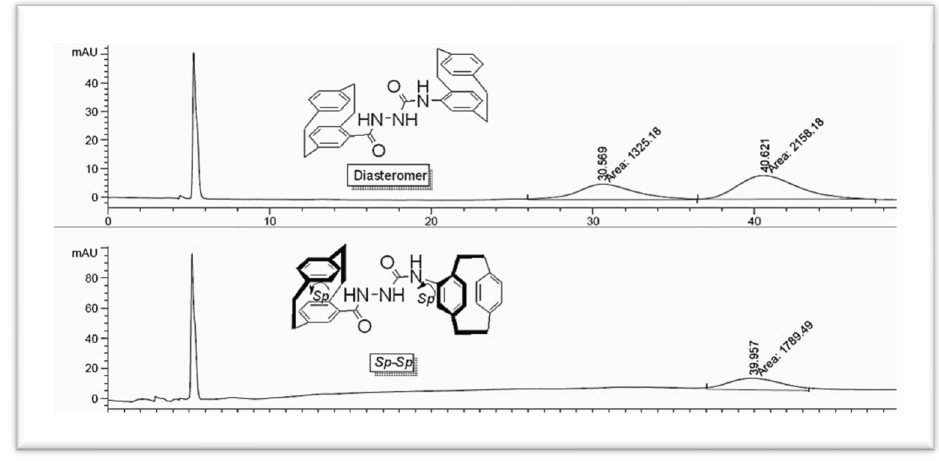
Sp - Sp - N -5-(1,4(1,4)-dibenzenacyclohexaphane-1 2 Figure 5. HPLC separation of Figure5. HPLCseparationof